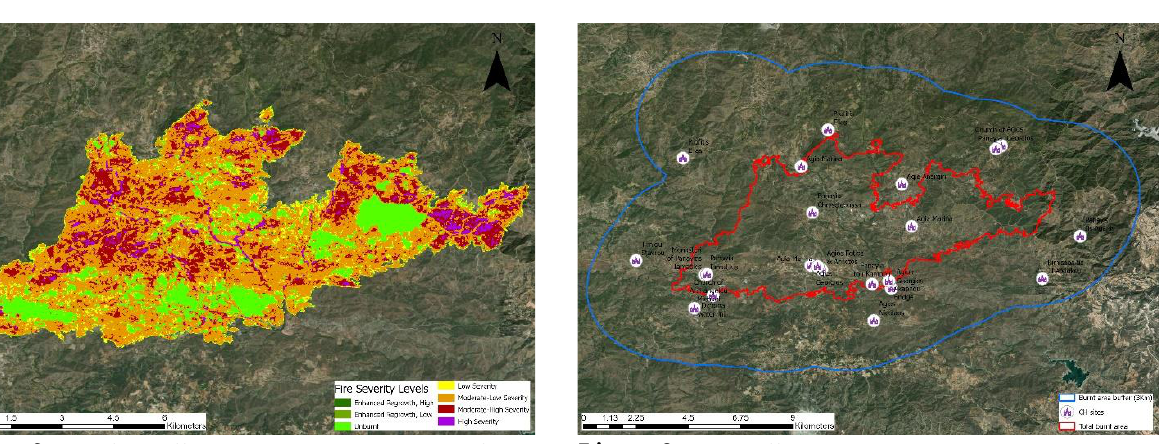
Figure 8 3Km buffer zone around the burnt area- and